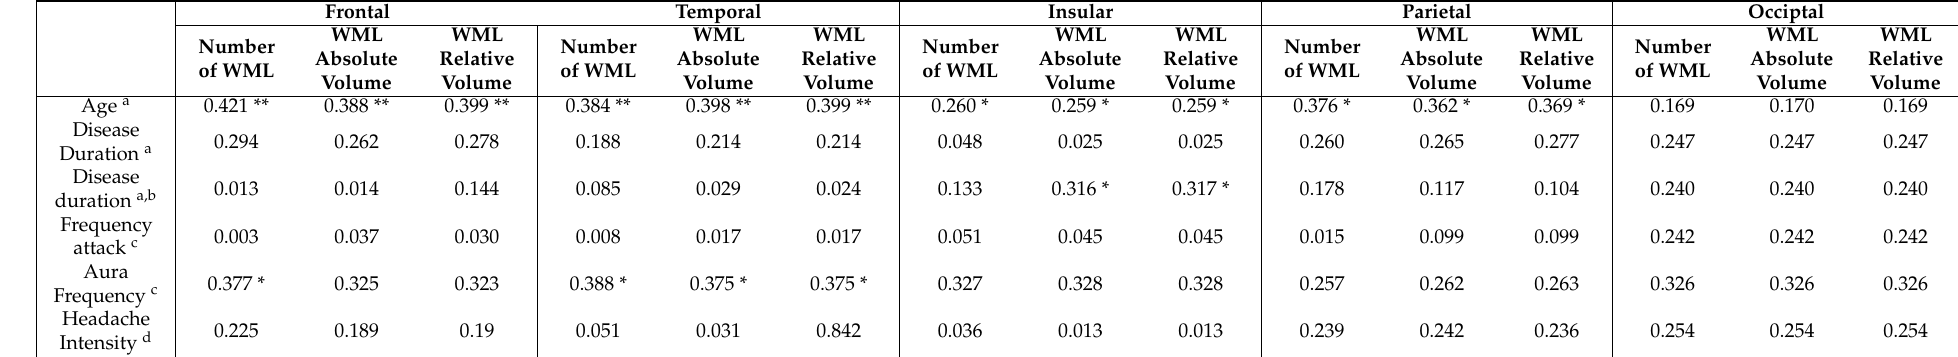
Table 3. Correlations between volumetric parameters by lobes and clinical features (Spearman’s correlation—r-value). Frontal Temporal Insular Parietal